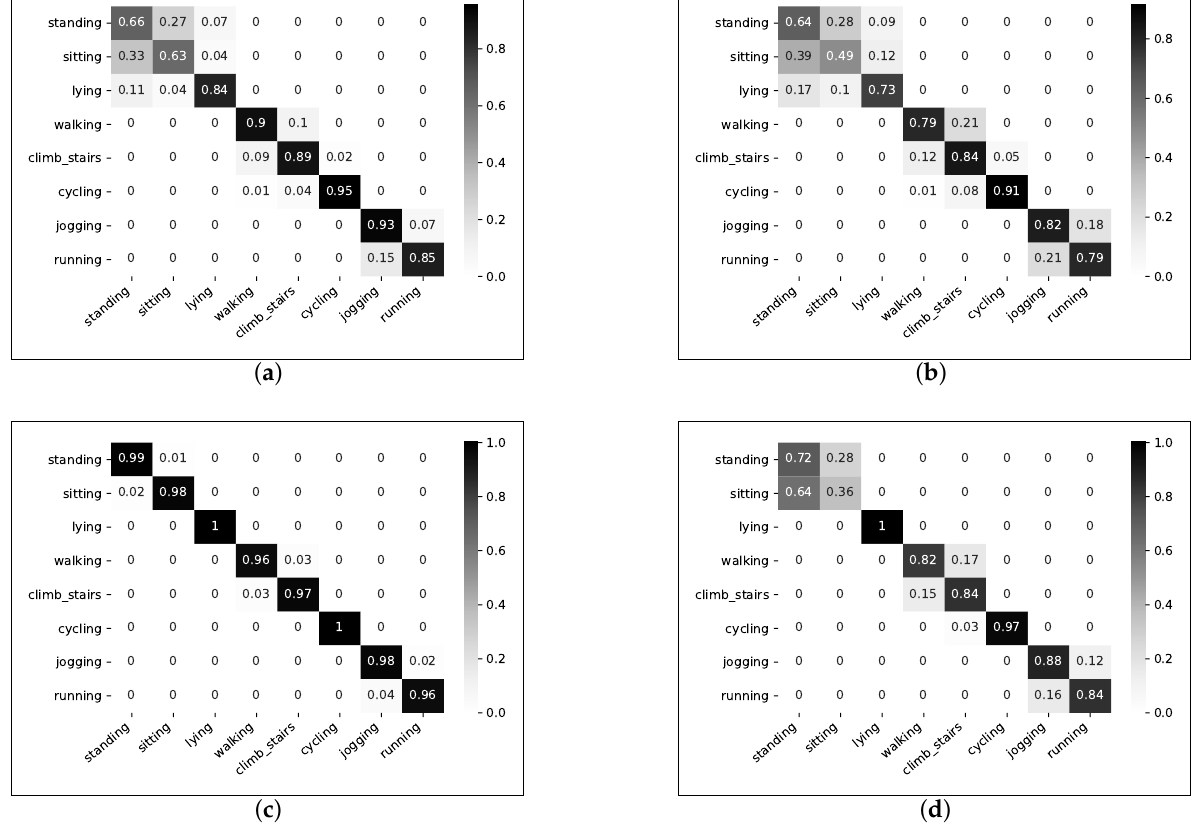
Figure 7. Confusion matrices for the RF classifier on the magnitude and raw accelerometer signals: ( a ) magnitude vector using 10-fold cross-validation; ( b ) magnitude vector using LOSO cross-validation; ( c ) raw triaxial vector using 10-fold cross-validation; ( d ) raw triaxial vector using LOSO